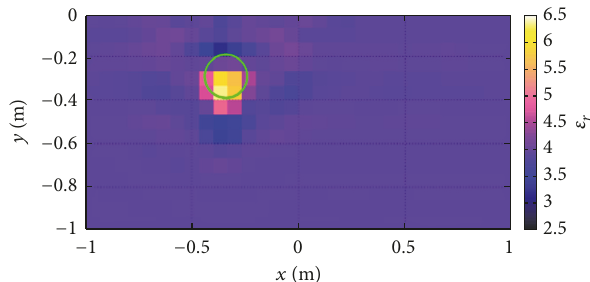
Figure 6: Reconstructed distributions of the relative dielectric permittivity in the investigation domain 𝐷 inv for SNR = 10 dB, obtained considering five frequencies in the considered band